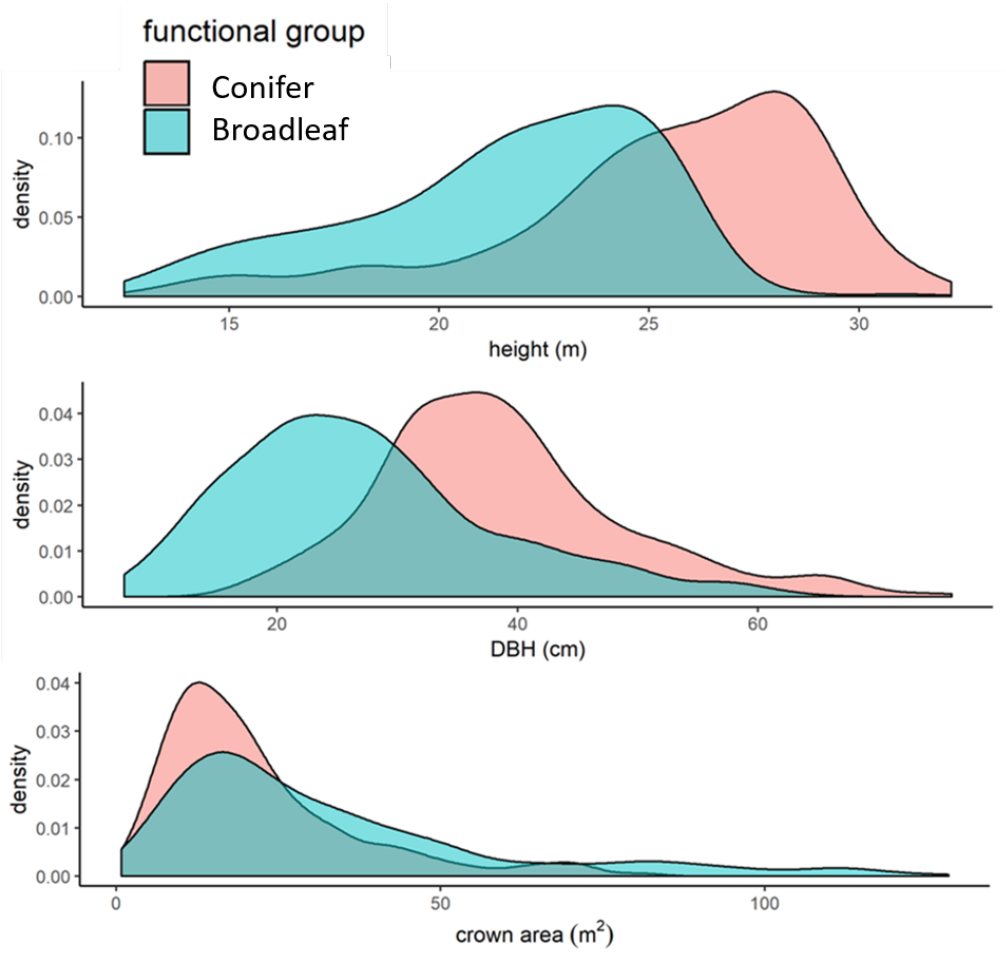
Figure 3. Density distribution of tree-level variables showing differences between conifer and broadleaf functional groups.